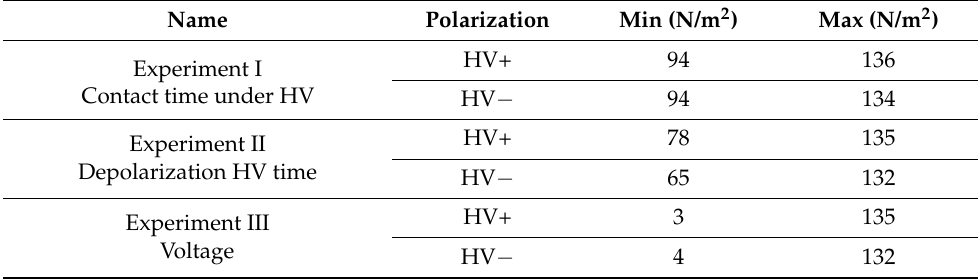
Table 1. Lowest and highest results of the measured electroadhesive force.